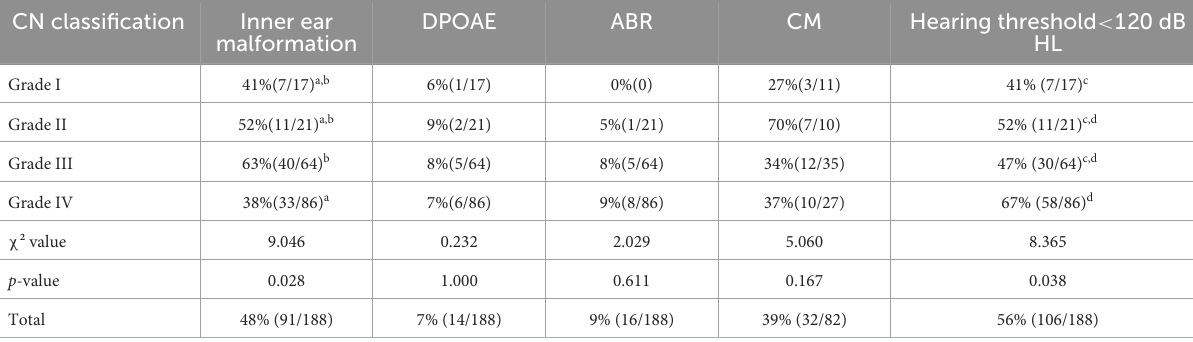
TABLE 2 Percentages of ears with inner ear malformations and elicitation rates of DPOAE, ABR, CM, and hearing threshold of < 120 dB HL grouped by the IAM nerve grading